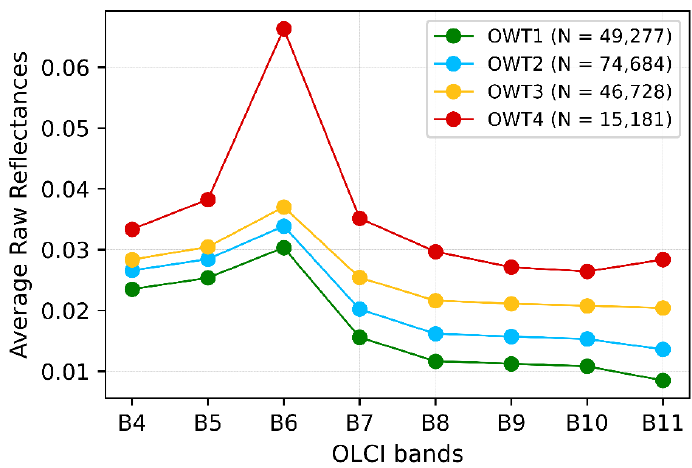
Figure 7. Average raw reflectance spectra derived for the k-means classification by class OWT.